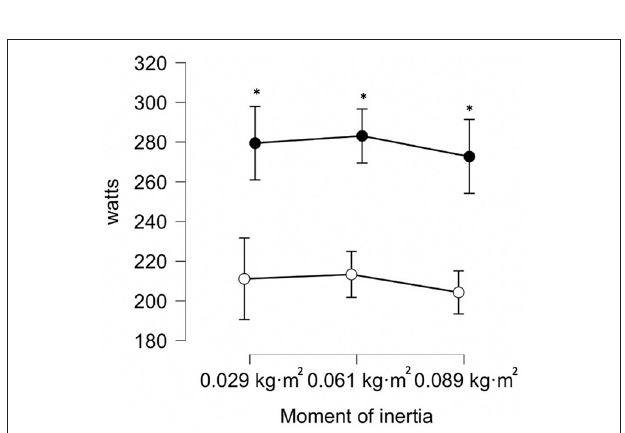
FIGURE 2 | Concentric and eccentric peak power during unilateral flywheel knee flexion. *Statistically significant ( p < 0.05) difference between concentric and eccentric peak power. Black dots = eccentric peak power values. White dots = concentric peak power